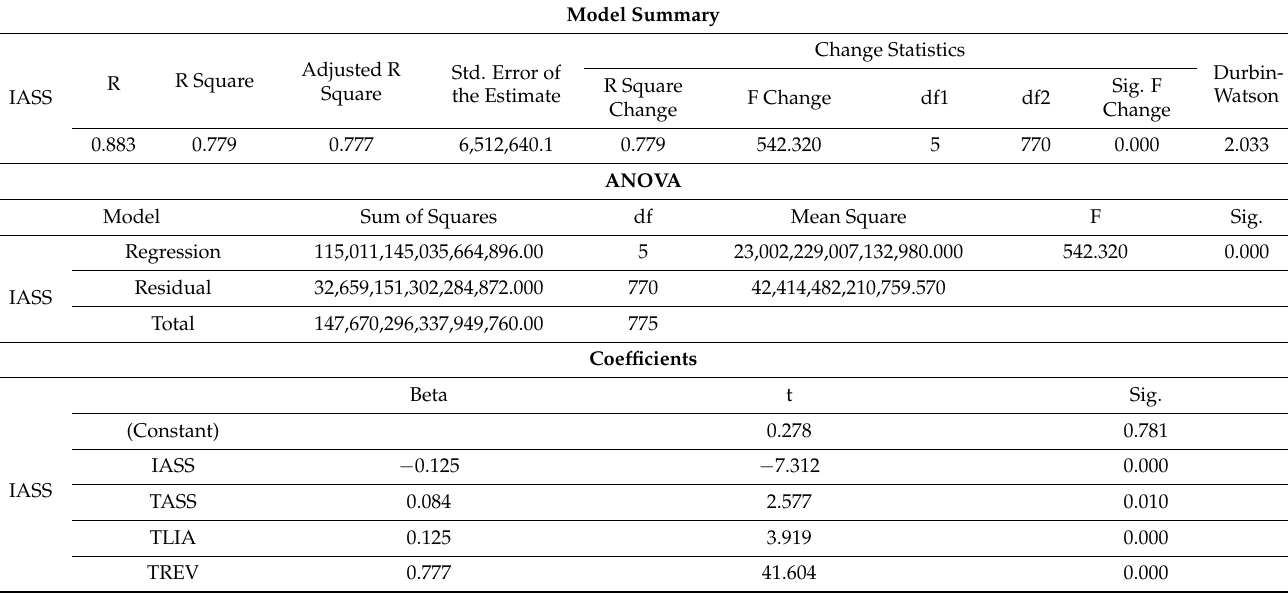
Table 13. Multiple regression analysis for factor